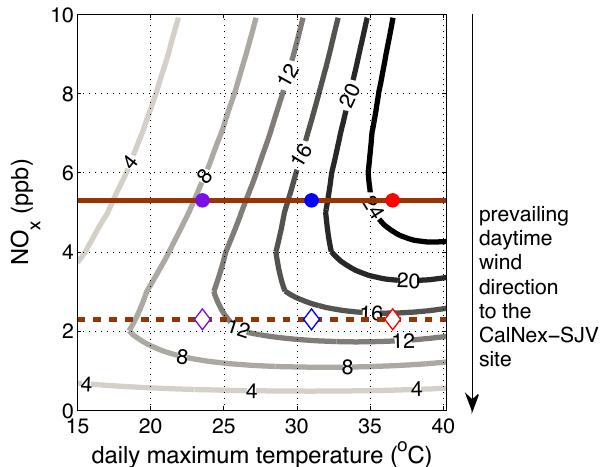
Fig. 6. P O 3 at 4, 8, 12, 16, 20, and 24ppb h − 1 as a function of NO x mixing ratio versus the daily maximum temperature ( ◦ C). Temper- ature here is a surrogate for VOCR. P O 3 is calculated with an an- alytical model constrained with the CalNex-SJV observations (see text for details). NO x (ppb) is shown for weekdays (solid brown line) and weekends (dashed brown line). The equivalent NO x R are 1.5 and 0.6s − 1 , respectively. The symbols are NO x mixing ratios at 2010-average low (purple), moderate (blue), and high (red) temper- atures on weekdays (closed circles) and weekends (open diamonds) for reference. The arrow along the right-hand side represents the prevailing daytime (10:00–14:00LT) wind direction with respect to NO x to the CalNex-SJV site, i.e., the wind travels from the higher NO x Bakersfield city center to the lower NO x measurement site.